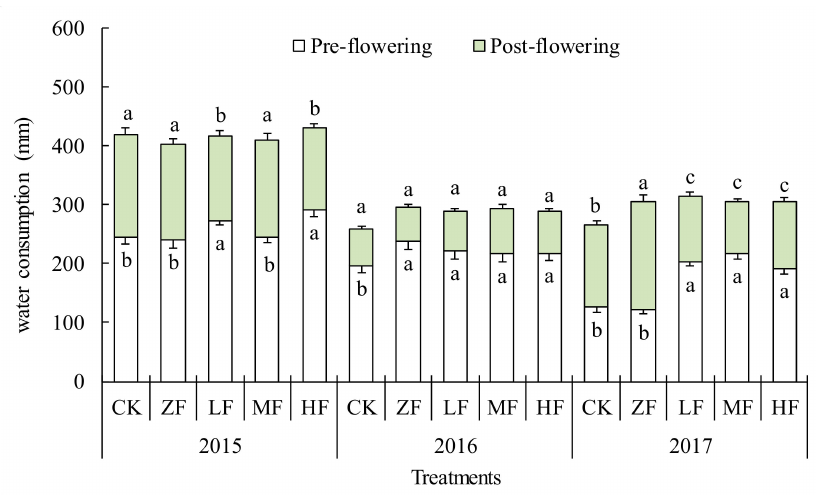
Figure 5. Crop water consumption of tartary buckwheat during the growing seasons of 2015–2017. In each growing season, mean values (n = 3) followed by different letters within a column are significantly different among treatments at p < 0.05. Bars are error bars of the means (n = 3).